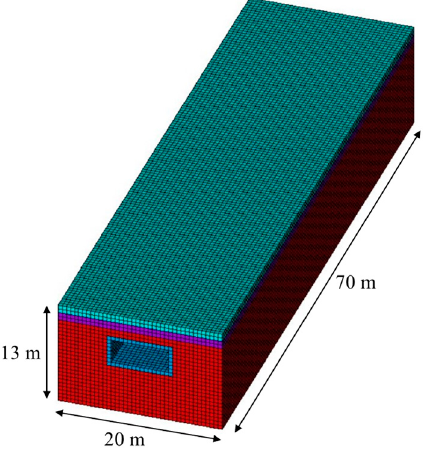
Figure 10. Numerical calculation model.